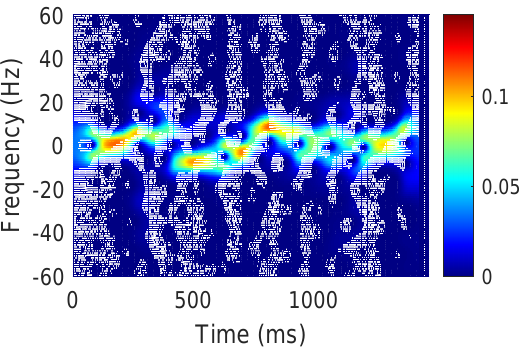
Figure 4. Power distribution spectrum caused by human gestures.